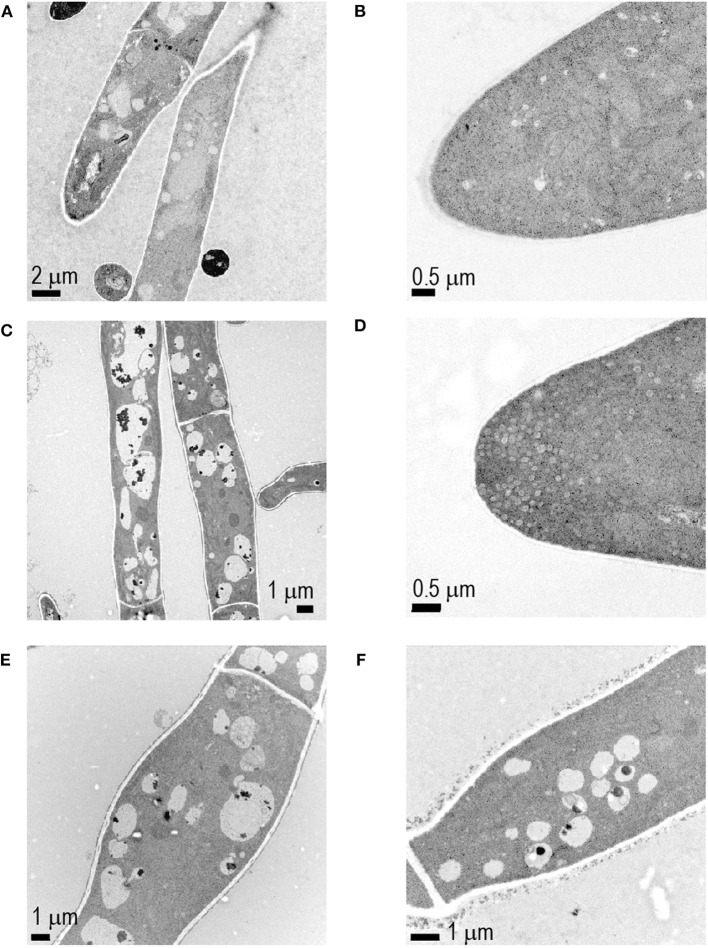
Ultrastructural analysis of Phoma sp. mycelia exposed to the bVOCs of C. vaccinii MWU328 (C–F). Phoma sp. mycelia not exposed to bVOCs were used as controls (A,B).